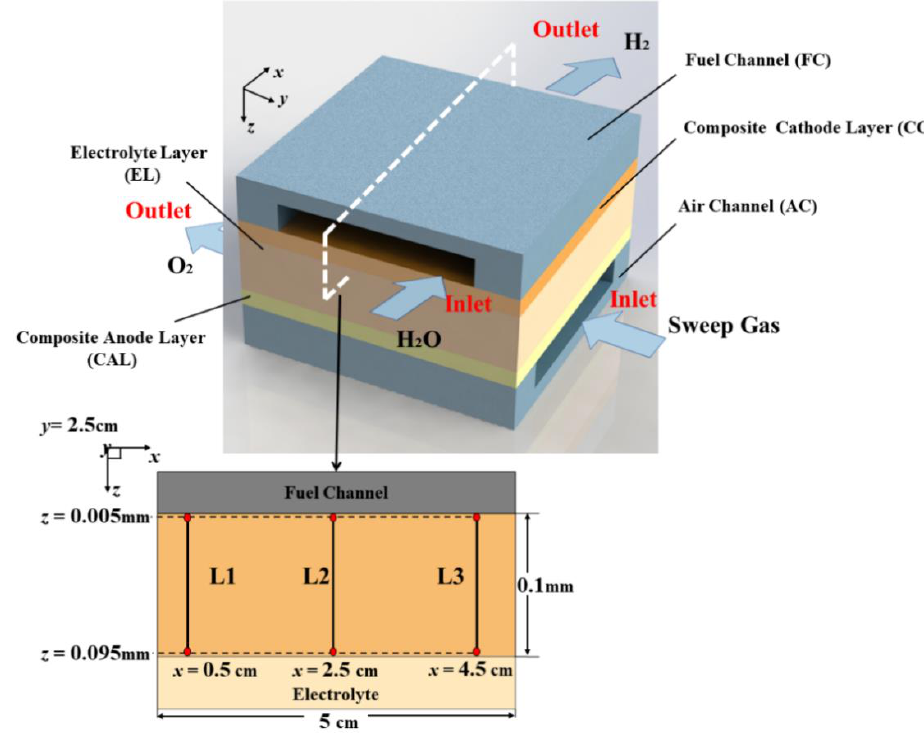
Figure 1. Geometric model of the IT-SOEC. Table 2. Sub-models and regions.